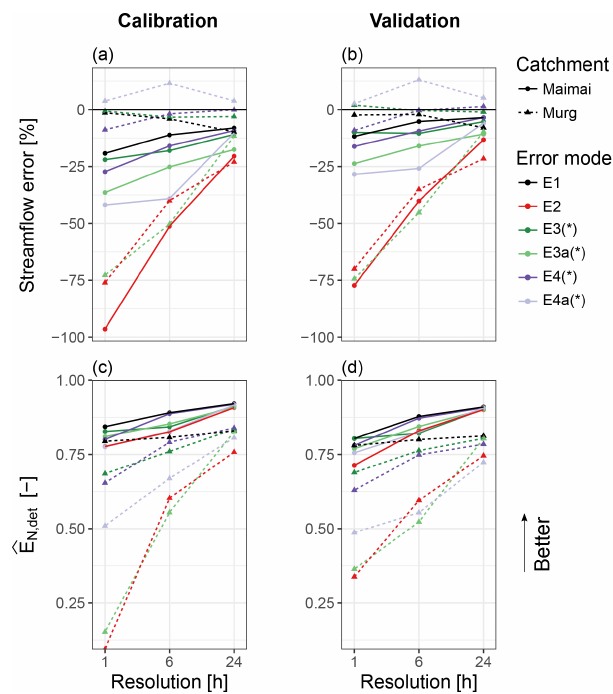
Figure 4. Performance of the error models in terms of the relative cumulative error in streamflow, (cid:49) Q , and the Nash–Sutcliffe effi- ciency, b E N , det , for both catchments and all temporal resolutions. P err was smoothed ( ∗ ) exclusively for hourly data in the Maimai